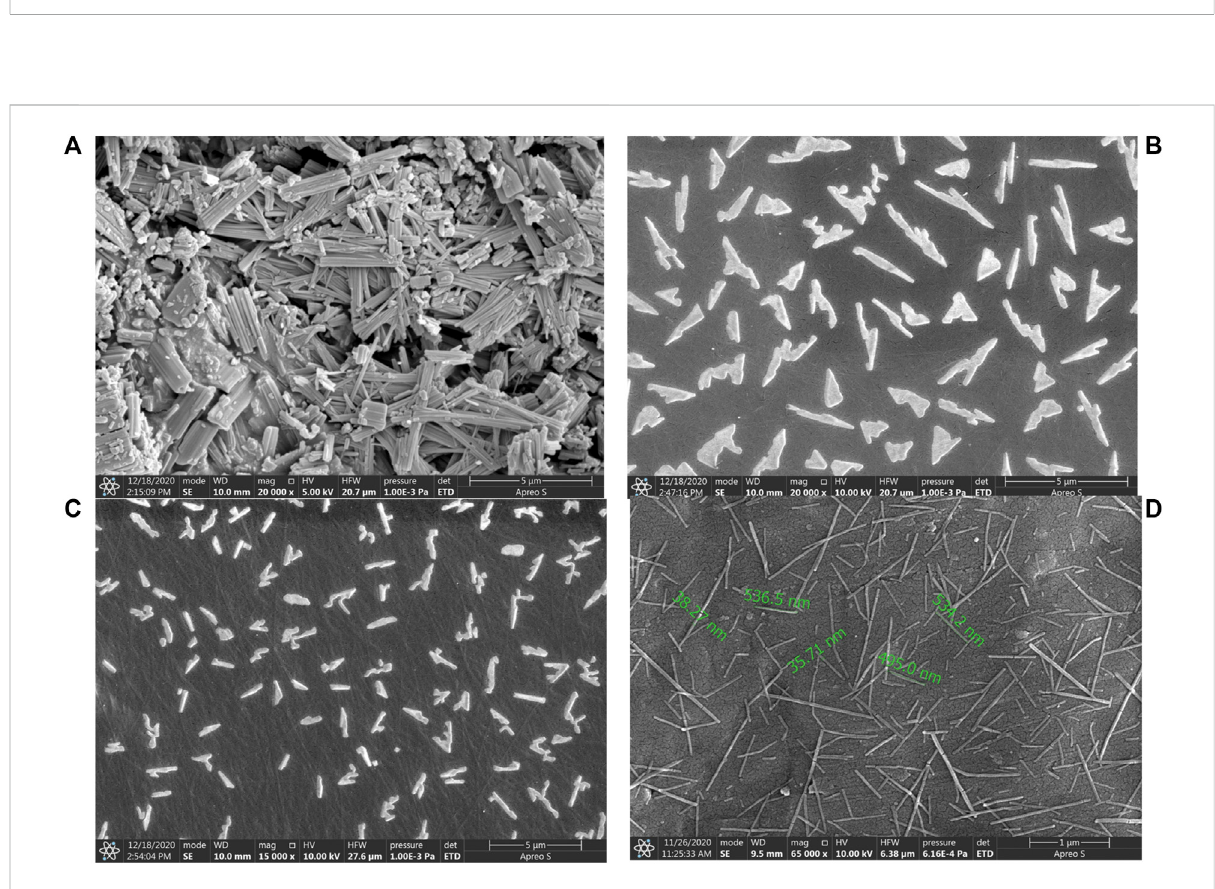
FIGURE 3 SEMimageofbulkRu fi (A) ,Ru fi -NCspreparedusingStandardrunnumber10(particlesizeof910 nmasperzeta-sizer) (B) ,Standardrunnumber 20 (particle size of 468 nm as per zeta-sizer) (C) and Standard run number 9 (particle size of 234 nm as per zeta-sizer) (D)